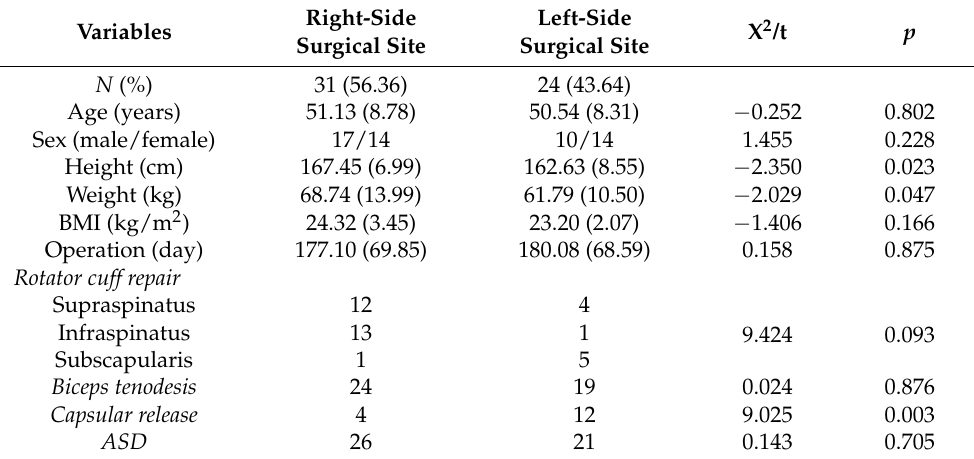
Figure 4. STROBE flow diagram. Table 1. The characteristics of the enrolled